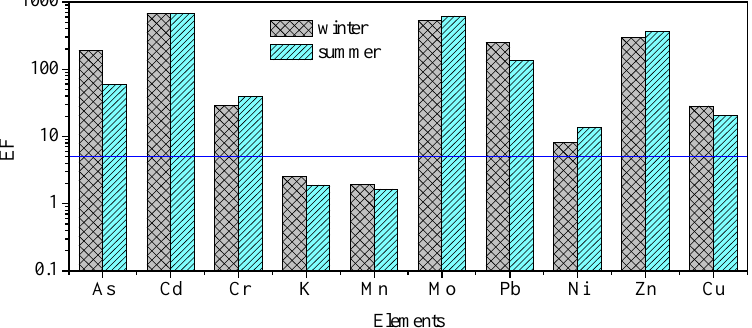
Figure 2. Elemental enrichment factors (EFs) relative to UCC (Earth’s upper continental crust, [22]) for elements in PM 2.5 (particles with an equivalent diameter equal to or below 2.5 μm) over Xi’an during winter and summer.